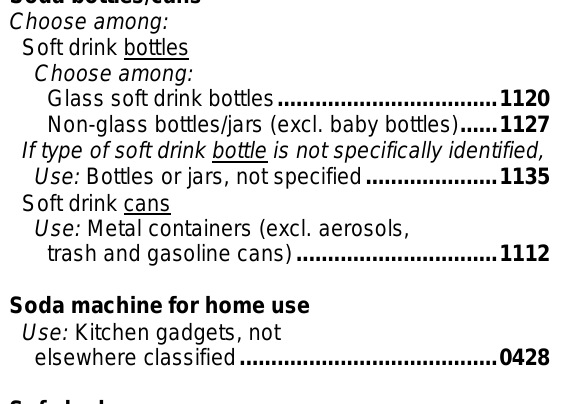
Snow globe Use: Knickknacks, statues, vases, or urns ........... 0654 Snow plows Snow plow should be coded according to what it is attached